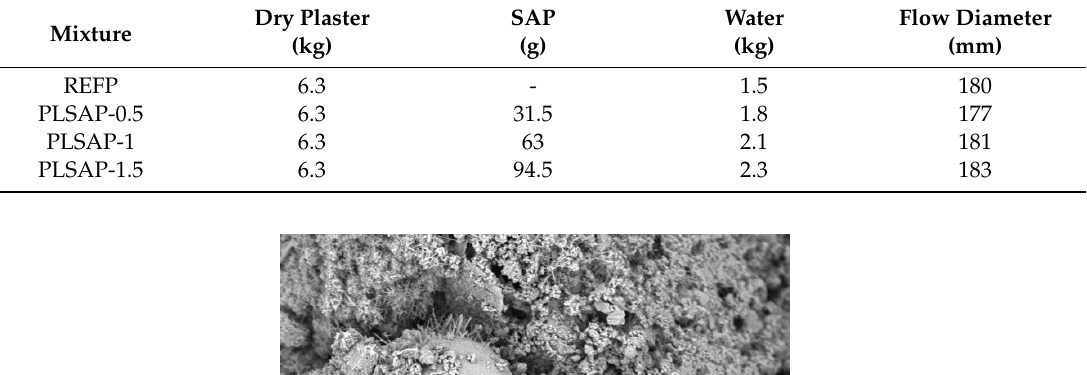
Table 1. Composition of the studied plasters.